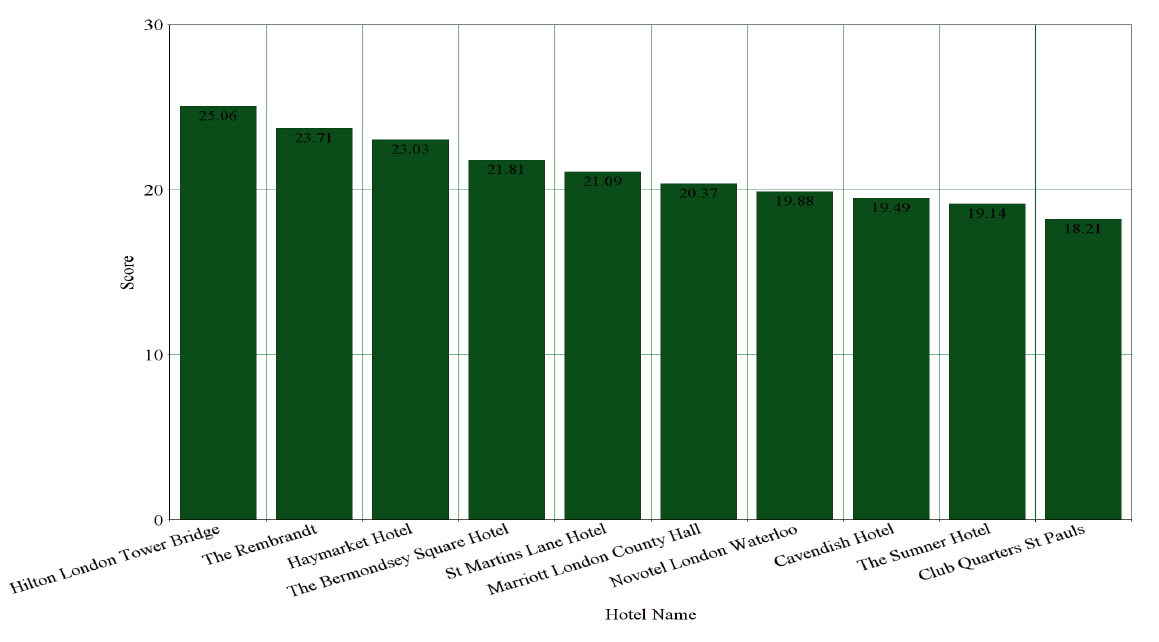
Figure 9. Top-10 Hotel Recommendation Generation by Our System for the 214 Common Hotels by considering the dataset of TripAdvisor.